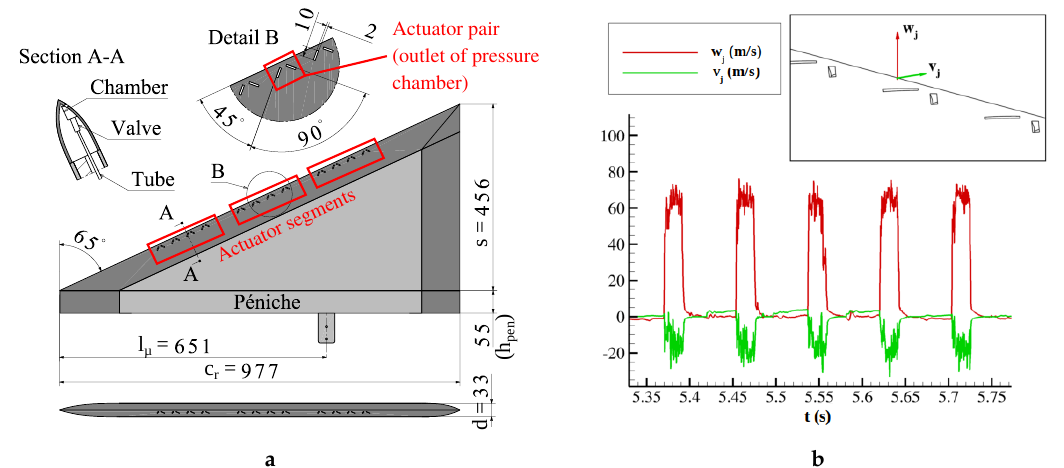
Figure 1. ( a ) Delta wing model (length dimensions in mm) and ( b ) measured slot exit velocity signal.